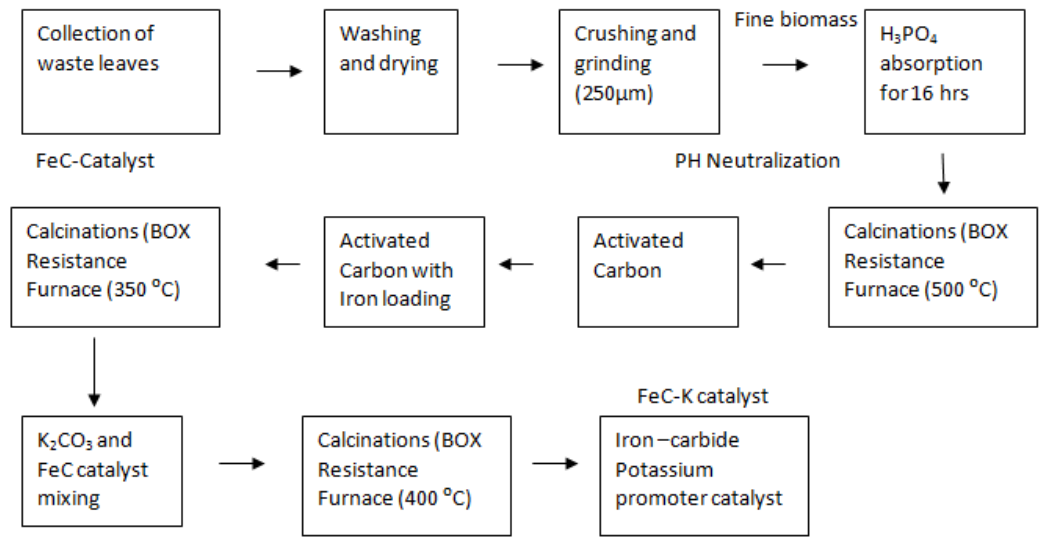
Figure 9. Synthesis of activated carbon-based catalyst by wet impregnation process.